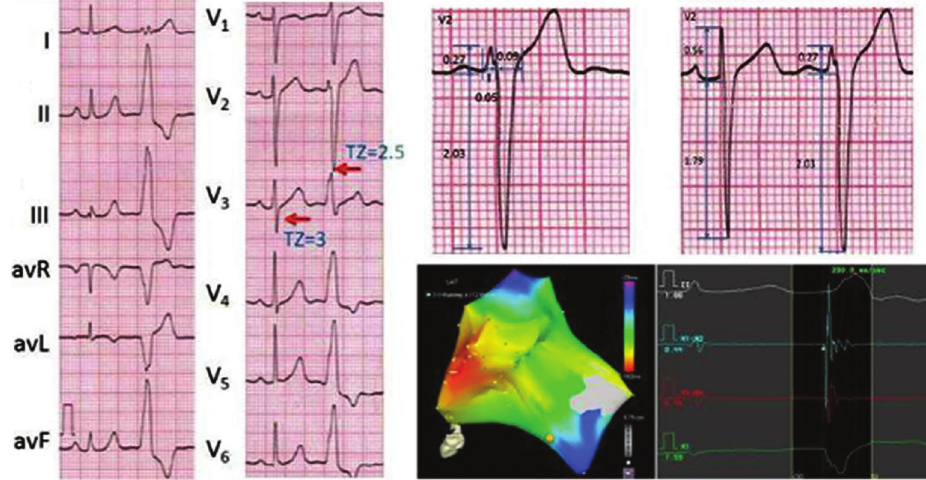
Figure 1. Electrocardiogram results used for differentiation of the origins of out fl ow tract ventricular arrhythmias (OTVAs) using three algorithms: transitional zone (TZ) index; V 2 transition ratio; and V 2 R wave duration and R/S wave amplitude indices. For this representative patient, the premature ventricular contractions transitional zone (TZ) score is 2.5, the sinus rhythm TZ score is 3, and the TZ index is – 0.5, indicating an aortic sinus cusp (ASC) origin OTVA. V 2 transition ratio was calculated as (R/R + S) OTVA /(R/R + S) SR = (0.27/2.03 + 0.27)/(0.56/1.79 + 0.56) = 0.73. V 2 R wave duration index = V 2 R wave duration/ duration from the starting point of QRS in